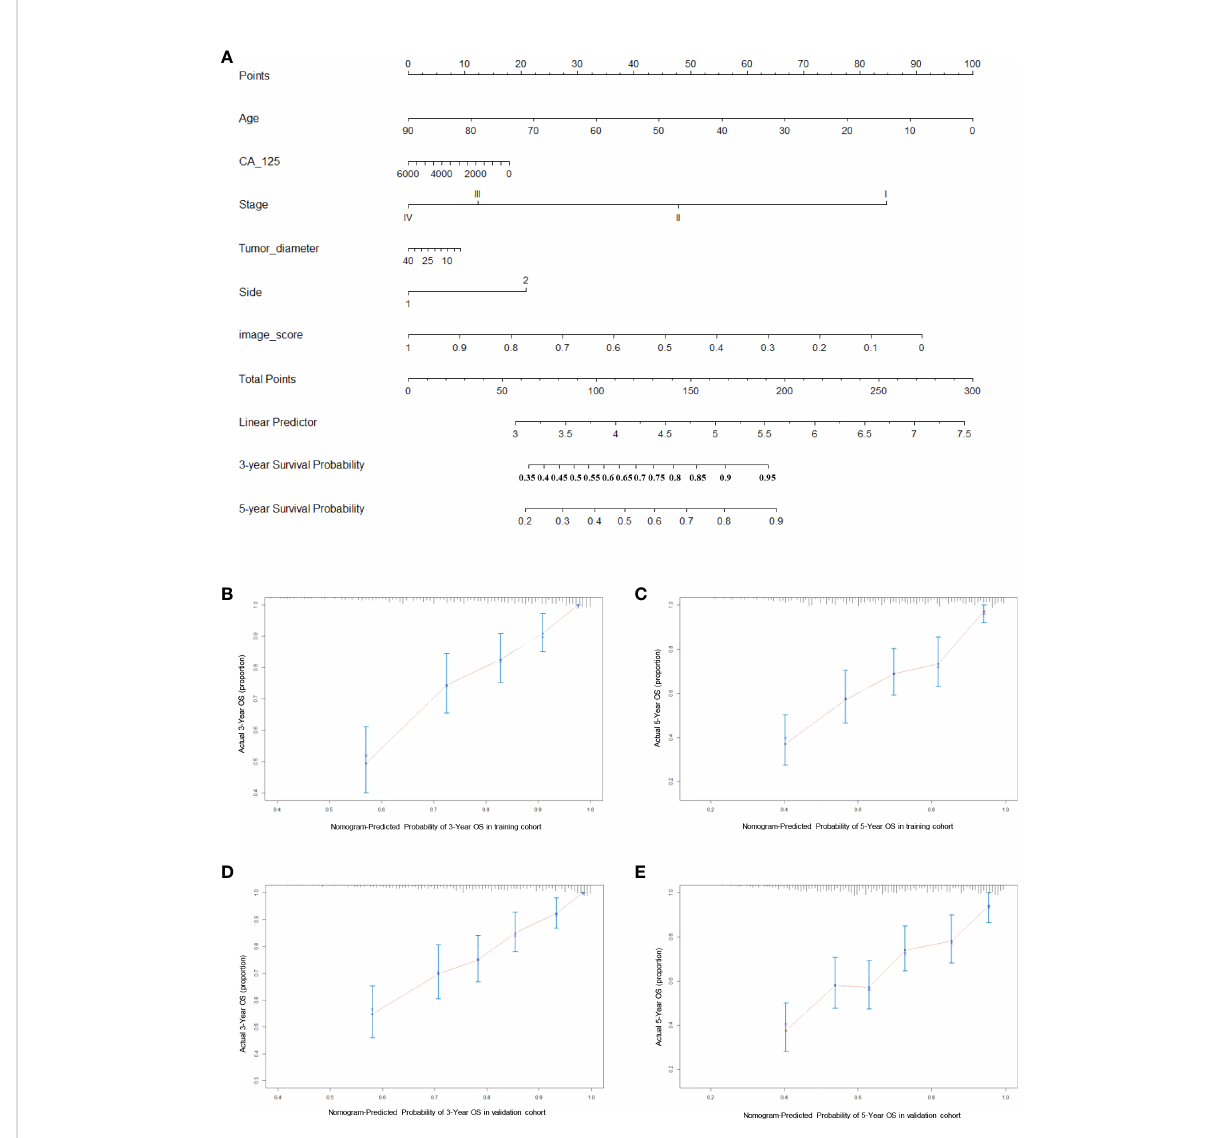
FIGURE 5 Generation and evaluation of nomogram. (A) A constructed nomogram for prognostic prediction of 3-year and 5-year overall survival for patients with HGSOC. (B, C) Calibration curves of 3-year and 5-year OS for HGSOC patients in the training cohort. (D, E) Calibration curves of 3-year and 5-year OS for HGSOC patients in the validation cohort. Dash line represents the ideal agreement, the red dots are calculated by